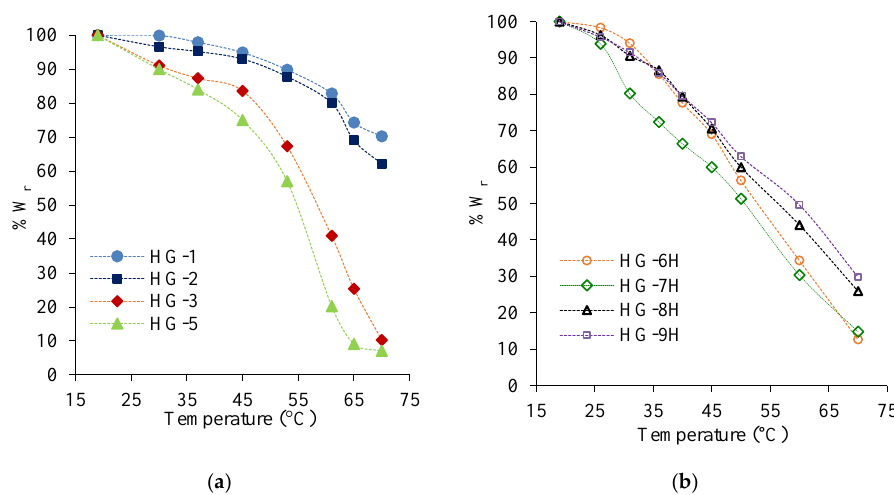
Figure 5. Temperature sensitivity for: ( a ) hydrogel HG-1 to -3, and -5 ( b ) hydrolyzed hydrogels HG-6H to -9H at pH 5.7.